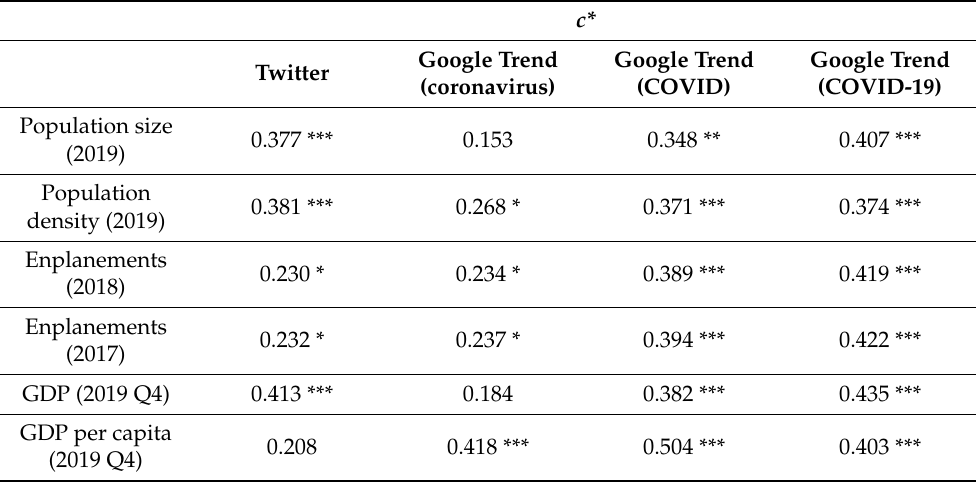
Table 1. The correlation coefficient between c* and states’ variables in terms of population demo- graphics, air traffic flow and the economic development level ( n = 50). The significance level is denoted by stars: * p < 0.1, ** p < 0.05, *** p < 0.01. c* Google Twitter